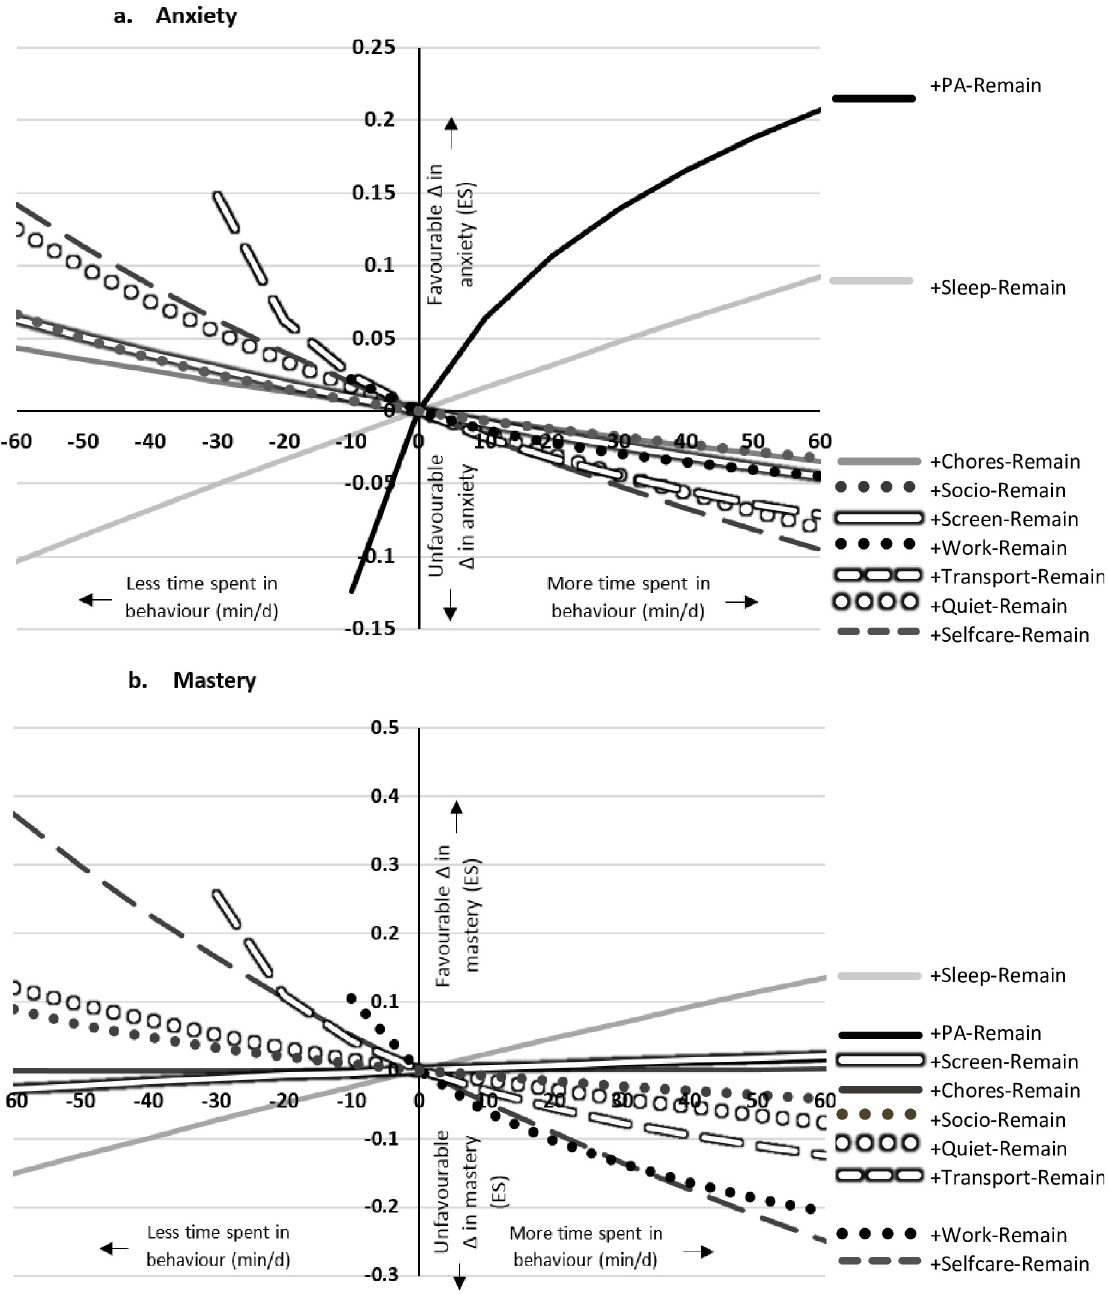
Fig 4. Effect on a) anxiety; and b) mastery when re-allocating time to each MARCA activity ‘superdomain’, by taking the time from the remainder of the composition . ES, effect size; PA, physical activity; Remain, remainder of the composition. Change ( Δ ) in outcome is presented as standardised effect